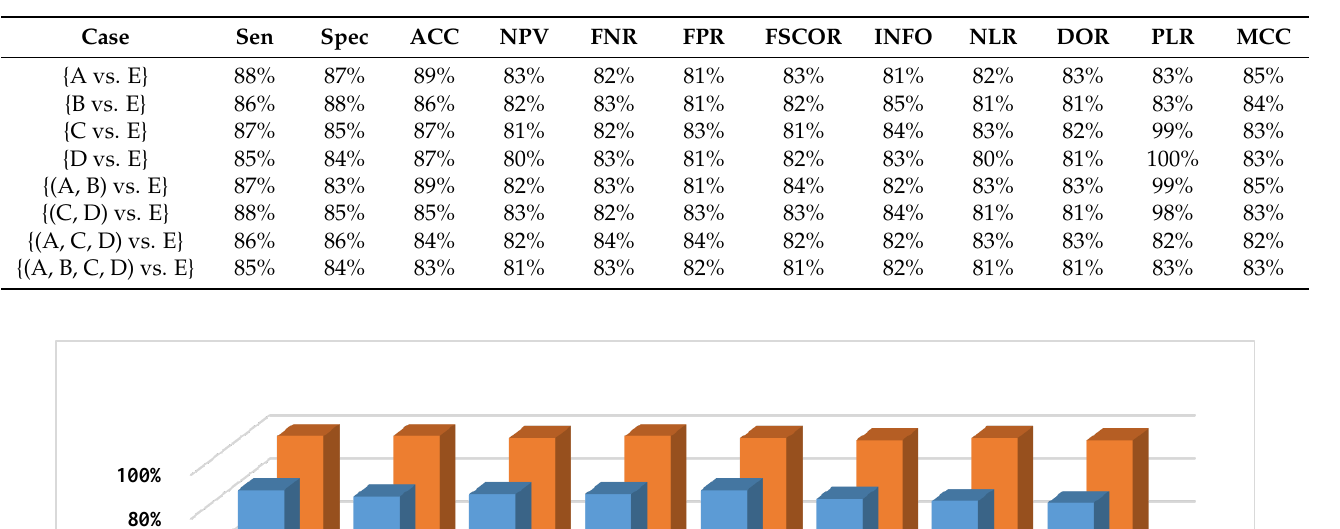
Table 7. Classification accuracy without feature selection.